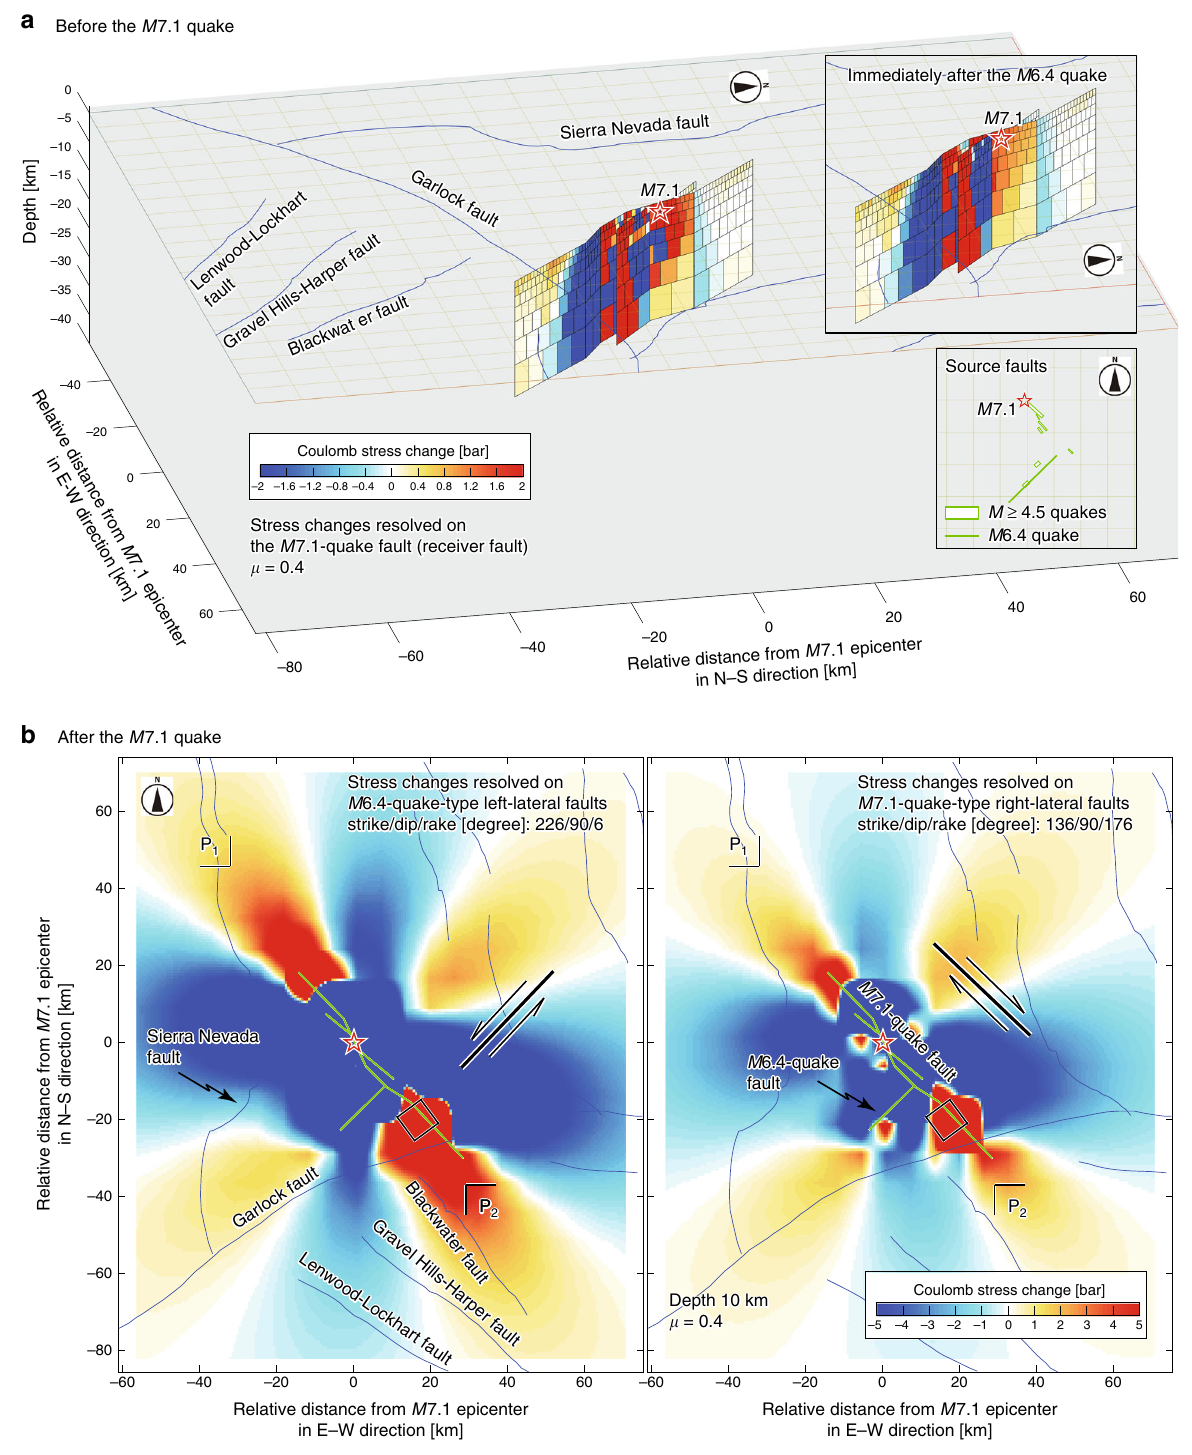
Fig. 3 Coulomb stress changes. a Stress changes resolved on the M 7.1 quake fault as a result of the M 6.4 quake and the following M ≥ 4.5 events. Star indicates the M 7.1 hypocenter. Top inset: changes in Coulomb stress as a result of only the M 6.4 earthquake, showing that the increase in stress near the region of the M 7.1 hypocenter was as high as 1 bar (orange). Bottom inset: source faults projected on the Earth ’ s surface. The M 6.4-quake fault is indicated by a segment because it is assumed to be a vertical plane. Rectangles indicate fault planes of M ≥ 4.5 events. For details on fault models, see Methods. b Changes in stress at a depth of 10 km as a result of the M 6.4 and M 7.1 quakes. Green segments indicate source faults ( M 6.4 and M 7.1 quakes). Left panel: changes in stress resolved on M 6.4-quake-type left-lateral faults (black line with a half-arrow pair). Right panel: changes in stress resolved on M 7.1- quake-type right-lateral faults. The rectangle indicates an area of low b -values shown by the rectangle in Fig. 2e that displays the cross-section extending from P 1 to P 2 . See Supplementary Figs. 11 and 12 for other